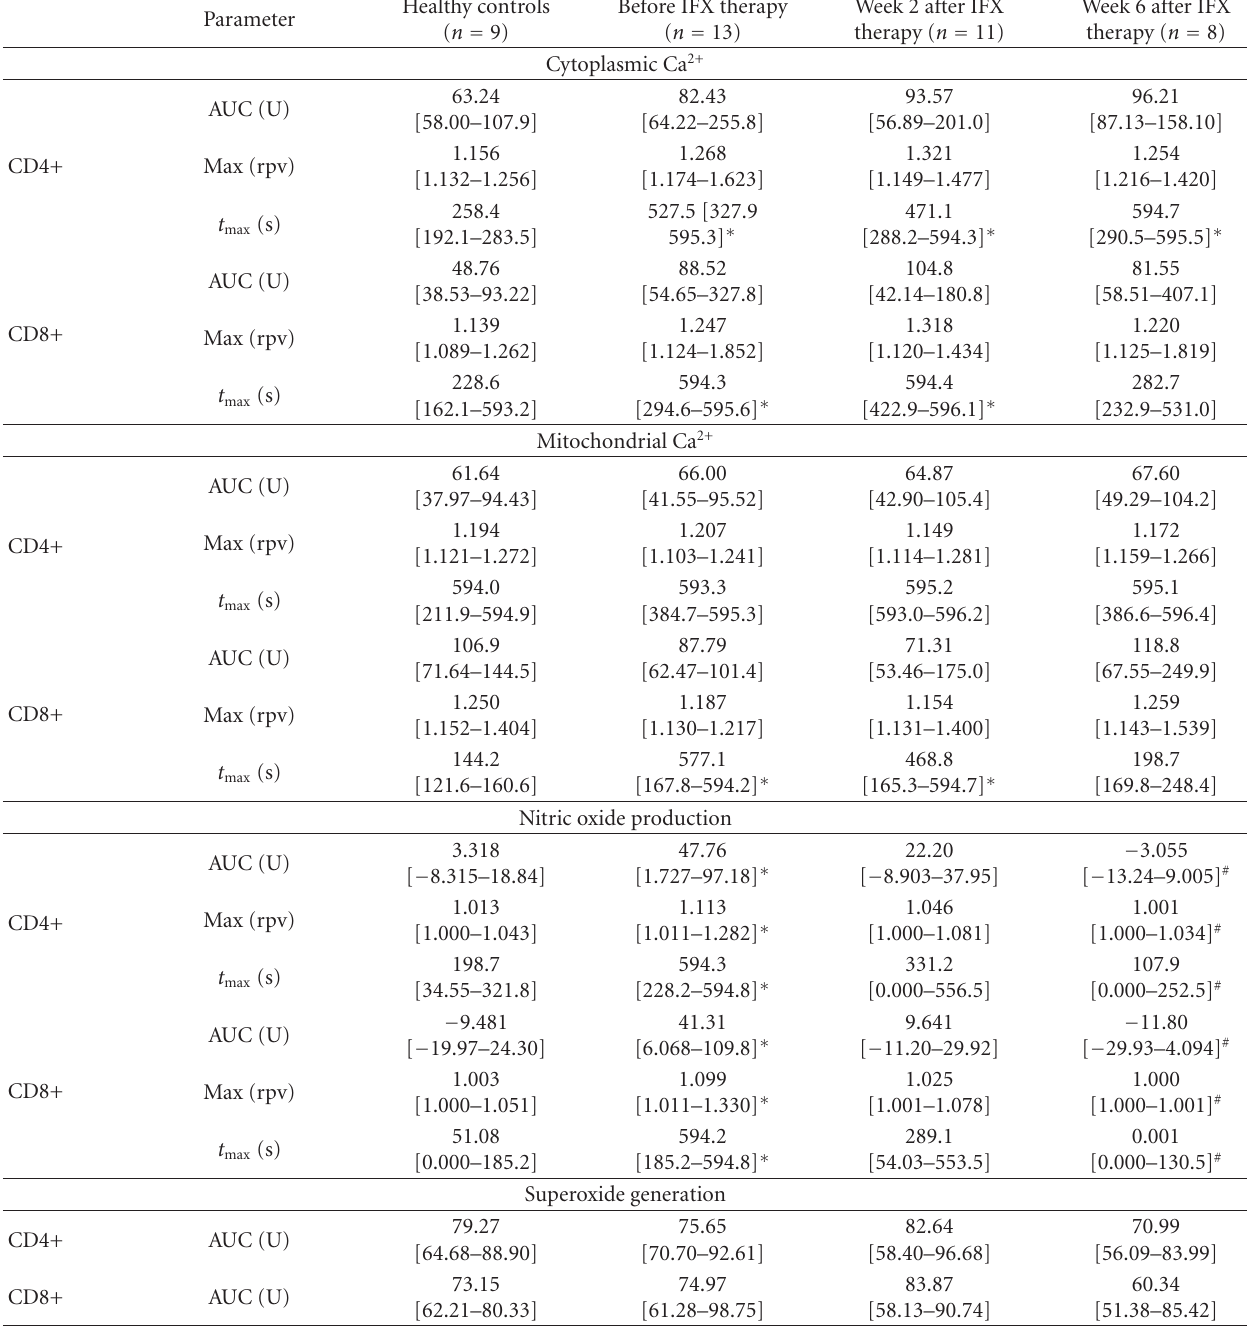
Table 2: Functional characteristics of intracellular processes in CD4+ and CD8+ cells following PHA activation in ankylosing spondylitis patients before and during infliximab (IFX)